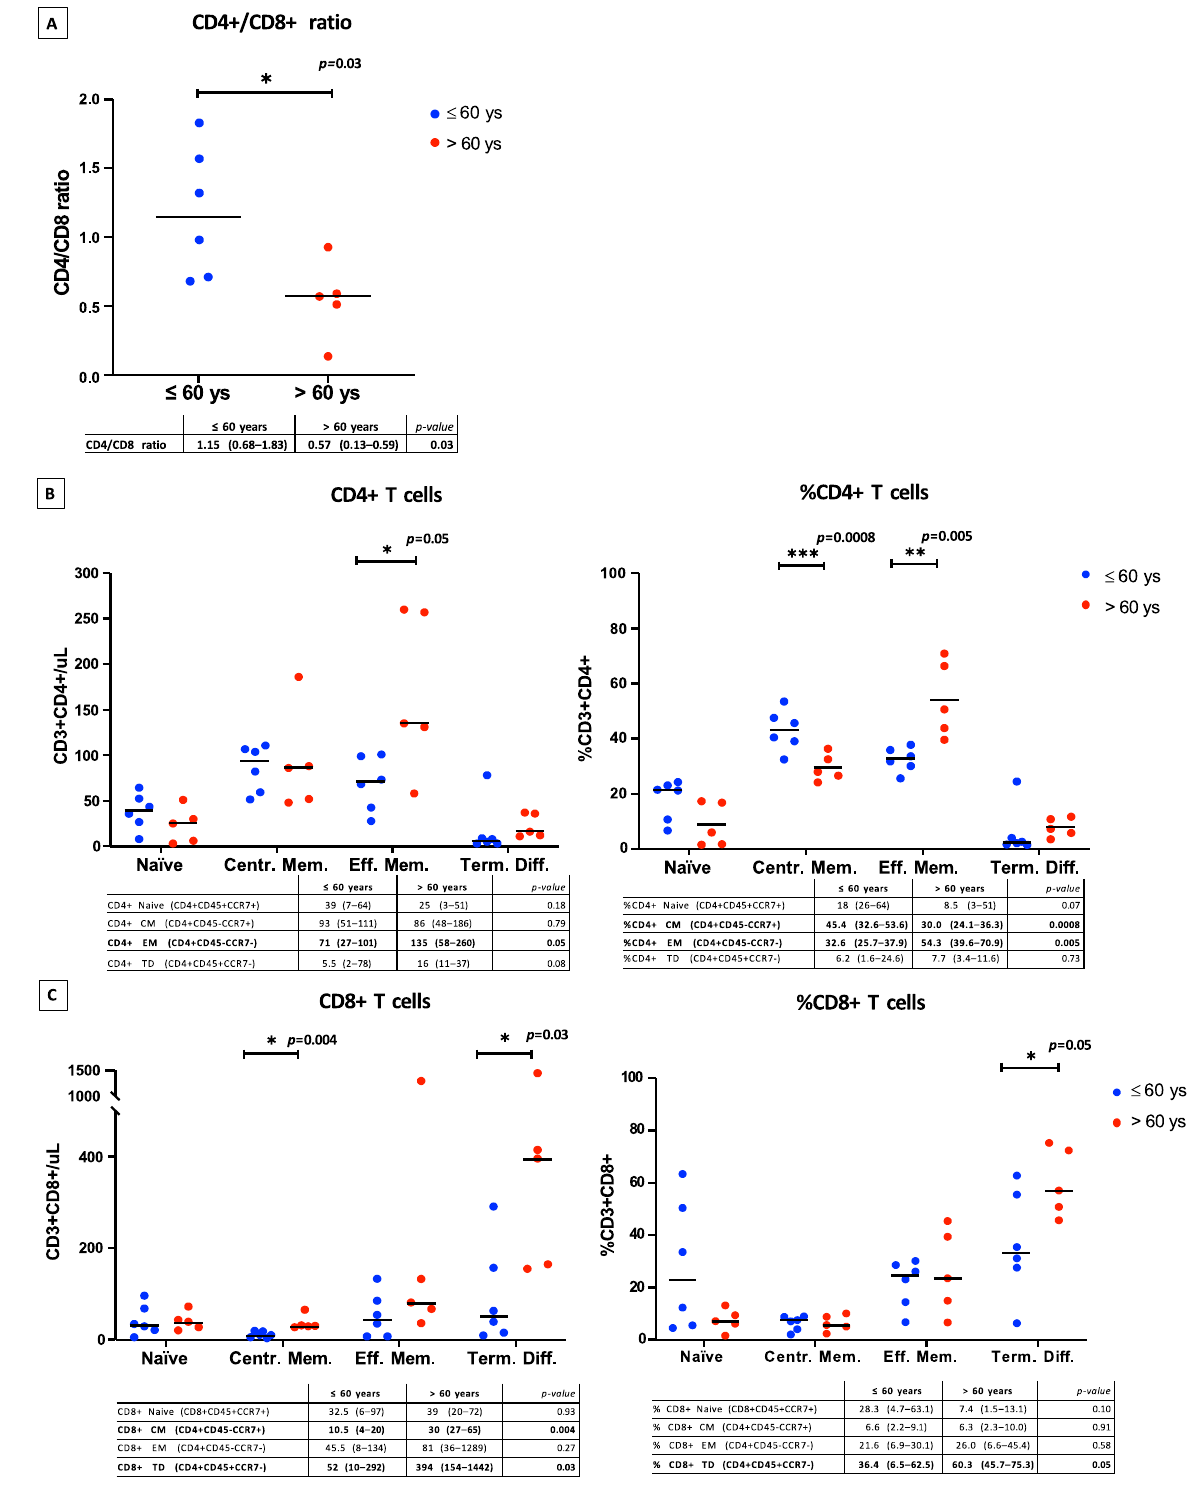
Figure 3. Ly-subsets in patients aged ≤ 60 years old (blue) and >60 years old (red). ( A ) CD4+/CD8+ ratio. ( B ) CD4+ T cell subpopulations evaluated as absolute counts (cells/ μ L) and as a percentage. ( C ) CD8+ T cell subpopulations evaluated as absolute counts (cells/ μ L) and as a percentage. * = statistical significance (i.e., p < 0.05); ** = statistical significance with p-value between 0.01 and 0.001. *** = statistical significance with p-value between 0.001 and 0.0001.